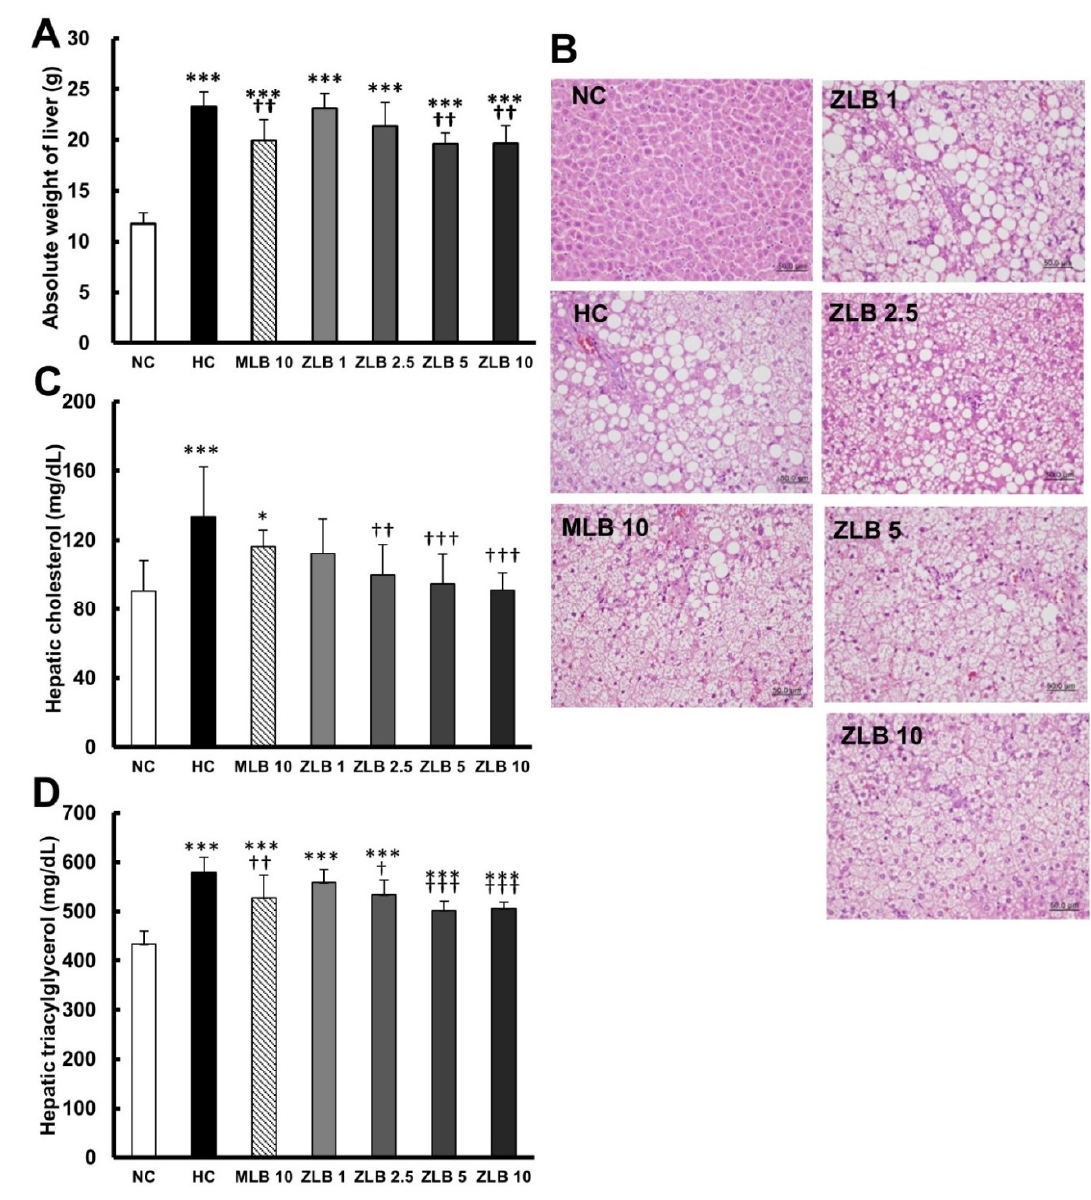
Figure 4. Effects of MLB and ZLB on lipid deposition in the liver. Weight of the liver was measured ( A ), and representative photomicrographs of liver tissues are shown at a magnification of ×400 ( B ). The levels of cholesterol ( C ) and triacylglycerol ( D ) in the liver tissues were measured. NC, normal diet control; HC, high-fat-diet (HFD) control; MLB10, HFD with 10 mg/kg/day of MLB; ZLB1, ZLB2.5, ZLB5, and ZLB10, HFD with 1, 2.5, 5, and 10 mg/kg/day of ZLB. Values are expressed as mean ± SD (n = 6 per group). * P < 0.05, *** P < 0.001 vs. NC group; † P < 0.05, †† P < 0.01, and ††† P < 0.001 vs. HC group.